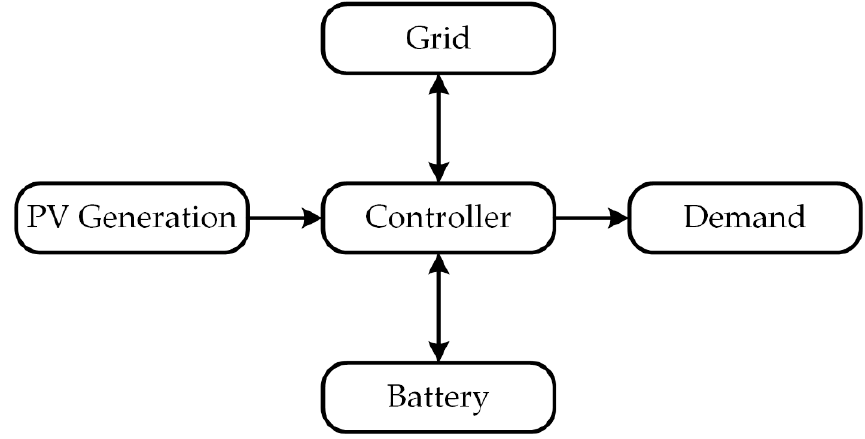
Figure 4. Block diagram of the proposed hybrid PV–BSS.